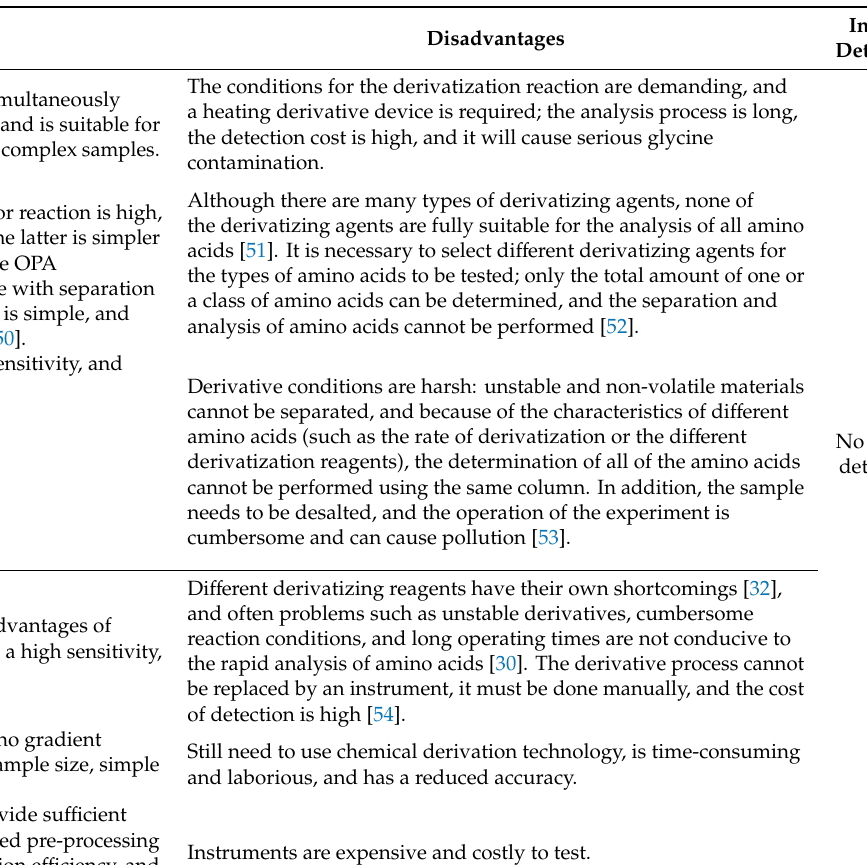
Table A1. Comparison of amino acid detection